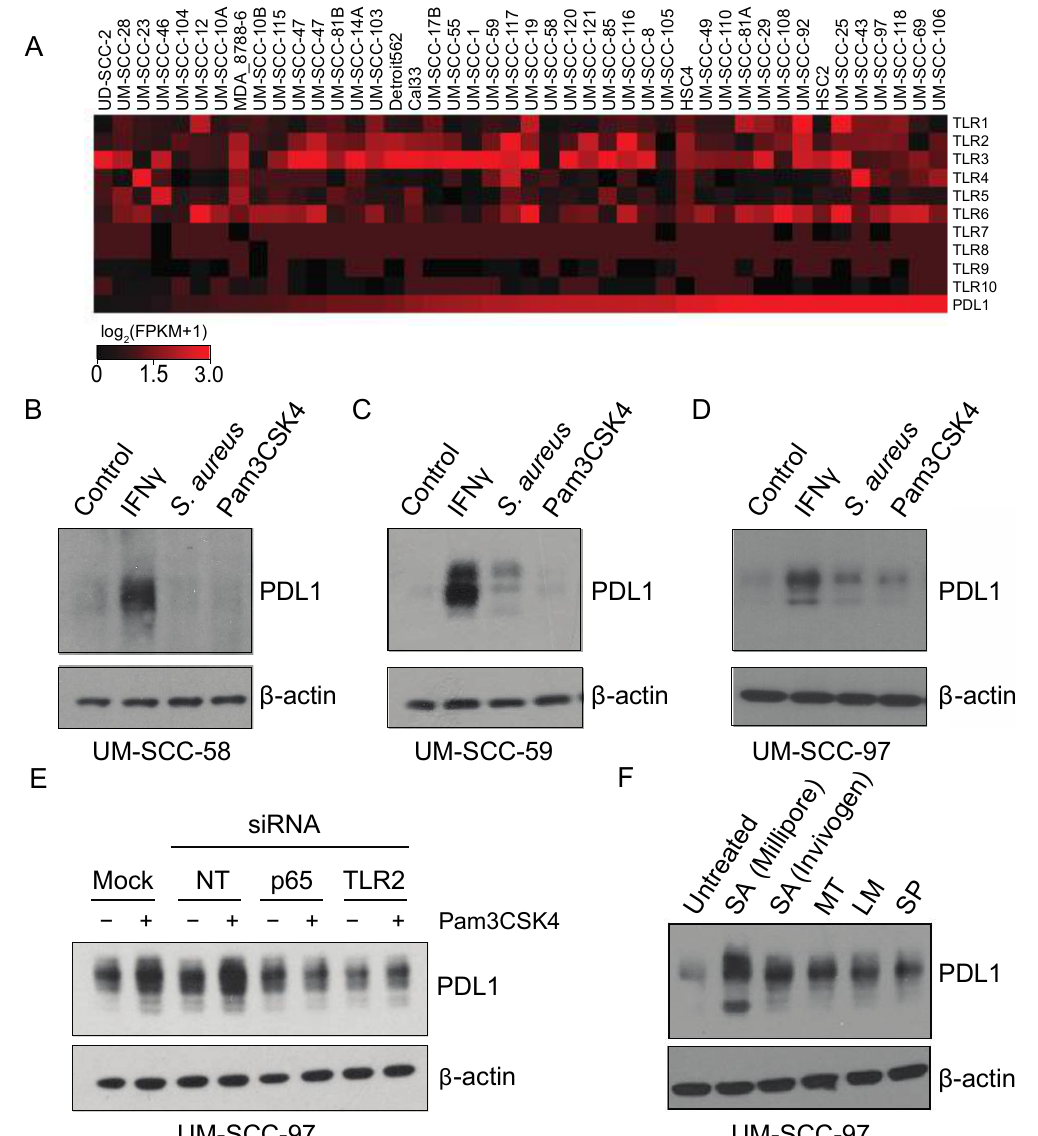
Figure 5. PAM4CSK4-mediated PDL1 stimulation is TLR2-dependent in HNSCC cell lines. ( A ) RNA expression (log2 (FPKM+1)) of indicated genes in HNSCC cell lines. RNA sequencing was performed for 43 HNSCC cell lines using Illumina stranded transcriptome library kits, as described in (Mann et al.) Heatmaps were generated using MeV software version 4.9 based on log 2 (FPKM+1) values. Cell lines are arranged from left to right in order of increasing expression of PDL1 (CD274). ( B – D ) HNSCC cells were treated with vehicle control, 10 ng/mL IFNγ, 0.075% S. aureus (Millipore), or 300 ng/mL Pam3CSK4 for 72 h. PDL1 expression was analyzed by immunoblot. ( E ) UM-SCC-97 cells were transfected with indicated siRNAs. 24 h post transfection, cells were treated with Pam3CSK4 for an additional 48 h. PDL1 was analyzed by immunoblot. ( F ) UM-SCC-97 was incubated with heat-killed commercially available bacterial strains as indicated for 72 h. Abbreviations: NT, Non-Targeting siRNA; SA, S. aureus ; MT, Mycobacterium tuberculosis; LM, Listeria monoytogenes; SP, Streptococcus pneumoniae.